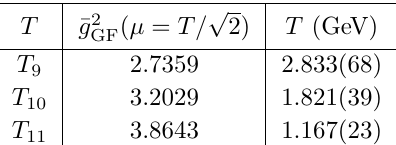
Table 5 . Values of the GF couplings corresponding to the lines of constant physical temperature that we